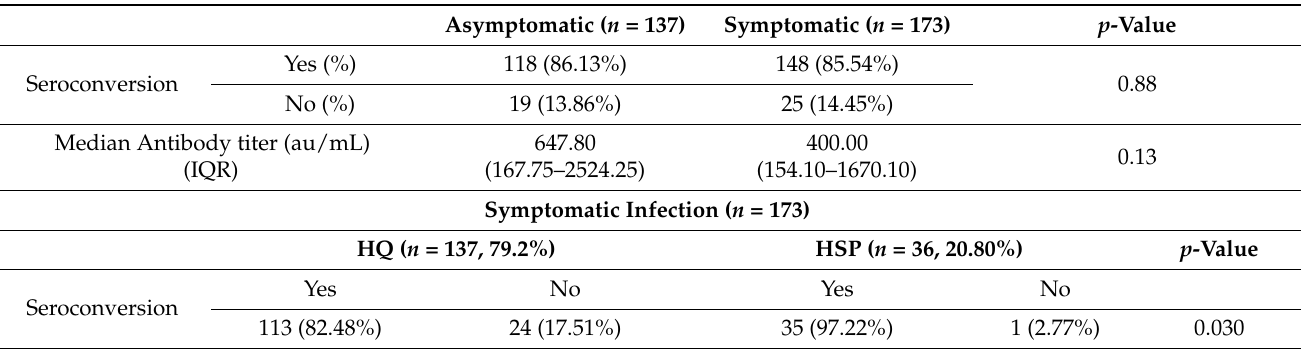
Table 4. Seroconversion rate in symptomatic (home quarantined or hospitalized) and asymptomatic